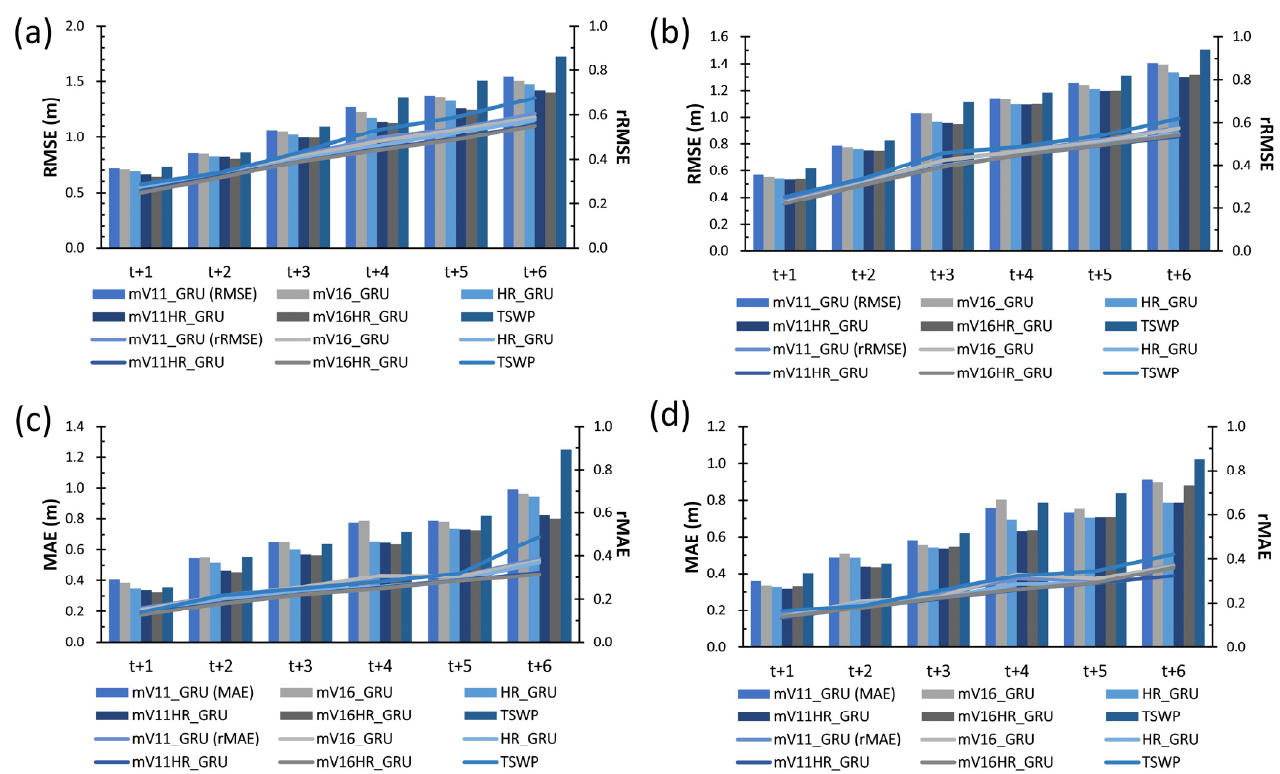
Figure 10. Metrics of ( a ) RMSE and rRMSE for the Longdong buoy, ( b ) RMSE and rRMSE for the Guishandao buoy, ( c ) MAE and rMAE for the Longdong buoy, and ( d ) MAE and rMAE for the Guishandao buoy.